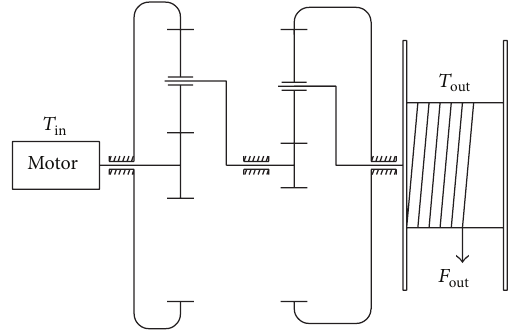
Figure 2: Schematic view of the lifting transmission system.